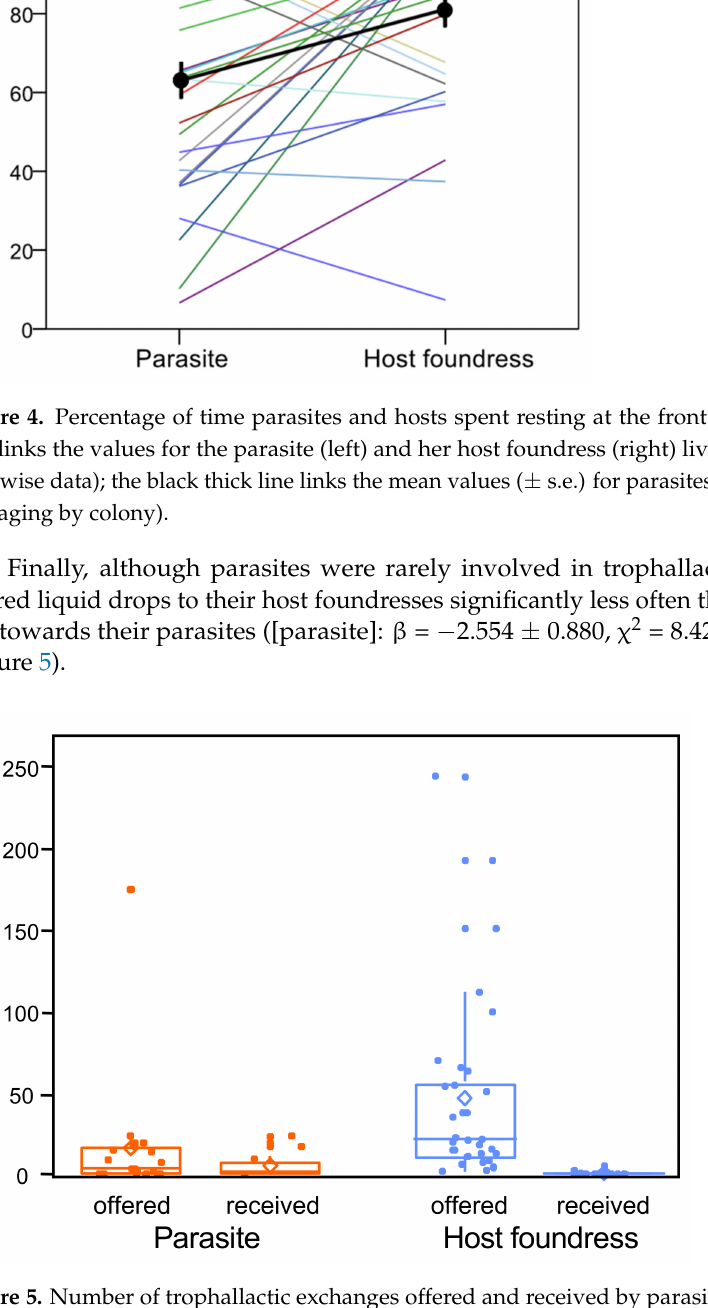
Figure 5. Number of trophallactic exchanges offered and received by parasites and hosts. The box- plots show medians, quartiles, 5th and 95th percentiles, and minimum and maximum values outside of the percentiles (color dots); diamonds represent means; points are jittered to prevent